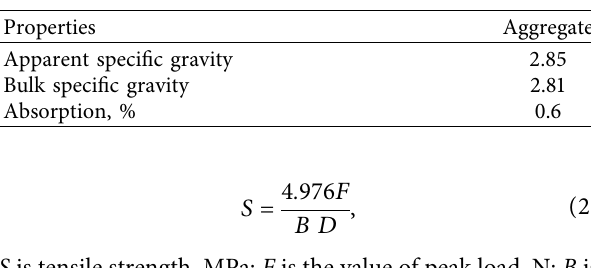
Table 3: Property of